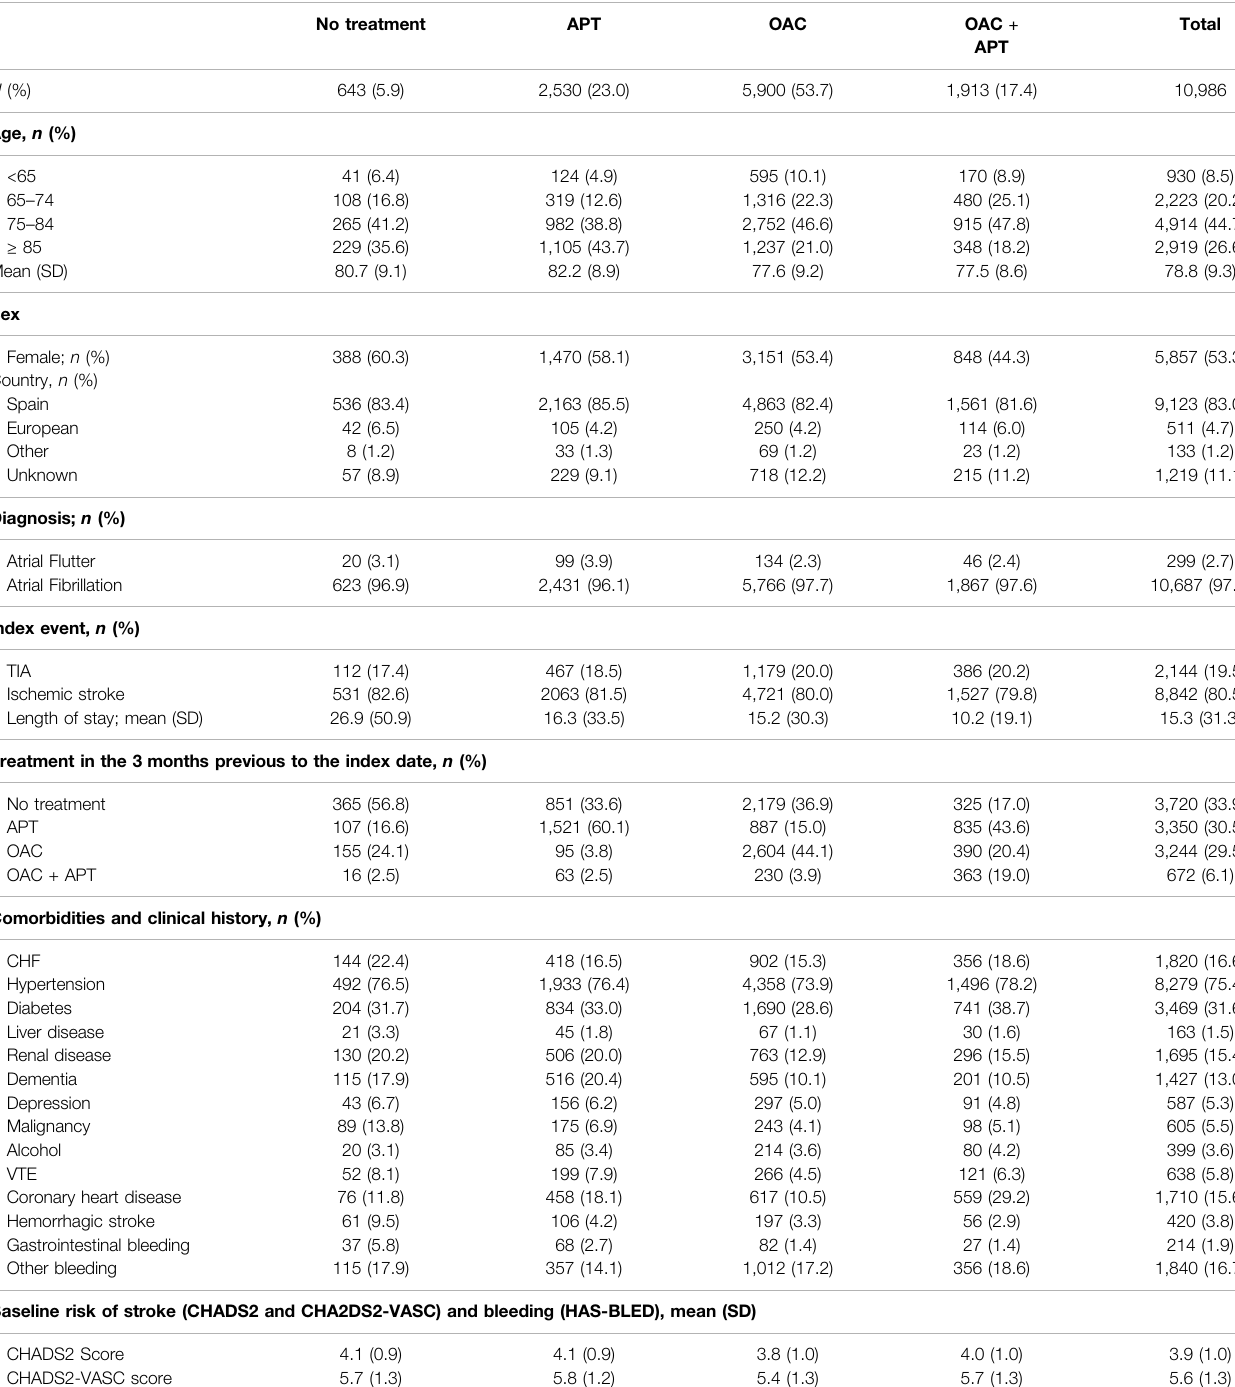
TABLE 1 | Characteristics of patients with atrial fi brillation who survived a stroke, by treatment strategy (secondary prevention). No treatment